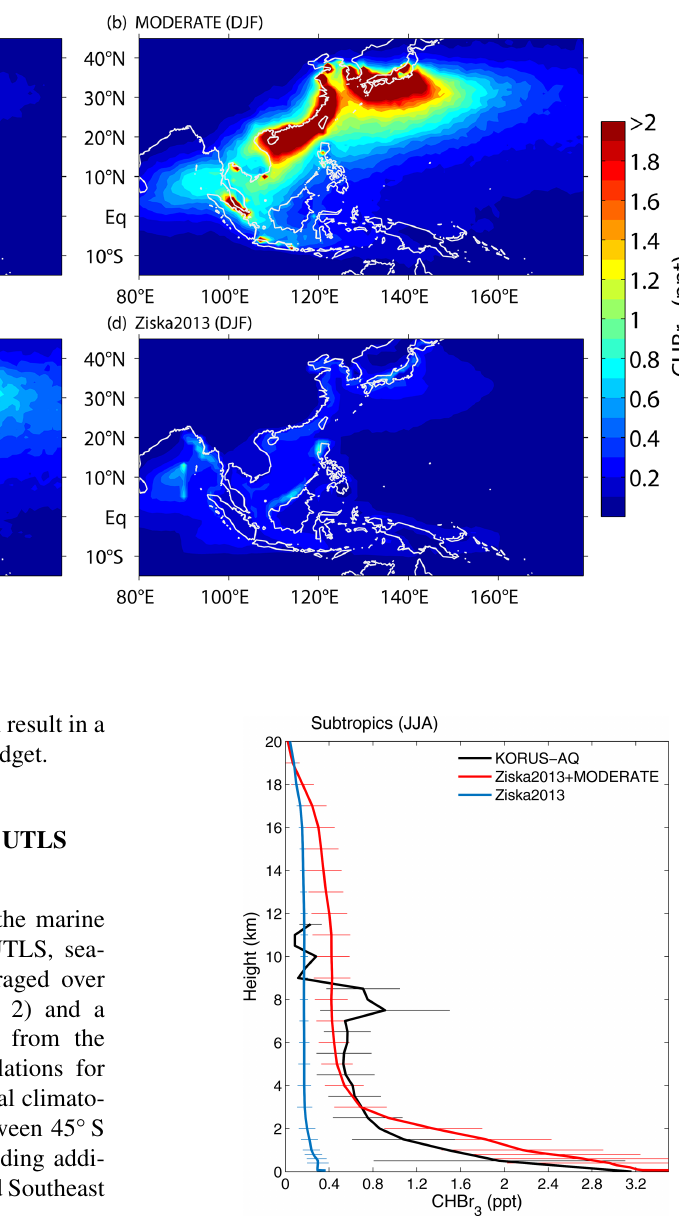
Figure 8. Height profile of seasonal mean bromoform mixing ratio [ppt] in the subtropics (30–40 ◦ N, 120–145 ◦ E) during JJA for the Ziska2013 + MODERATE run (red) and the Ziska2013 run (blue). Additionally shown is the averaged profile of bromoform measure- ments from the KORUS-AQ campaign over South Korea and the Yellow Sea (black). Horizontal lines show the standard deviation for specific